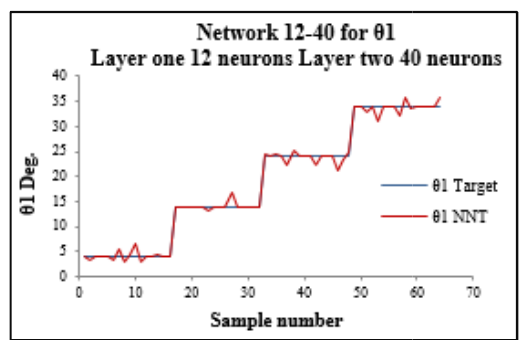
Fig.19. θ 1 Target Vs. θ 1 neural network two layers